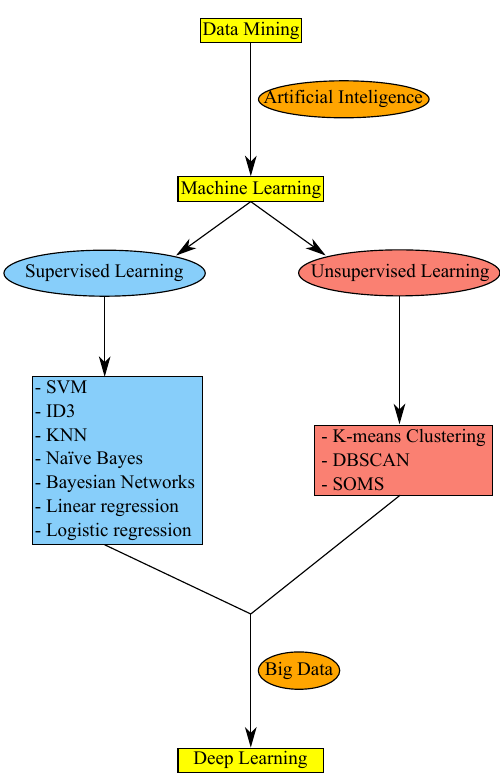
Figure 4. Methodology of the intelligent data